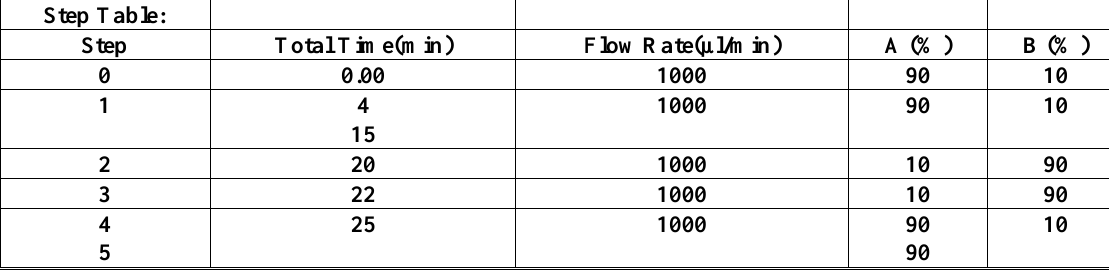
Table 3. Time and flow rate of analyzed compounds Step Table: